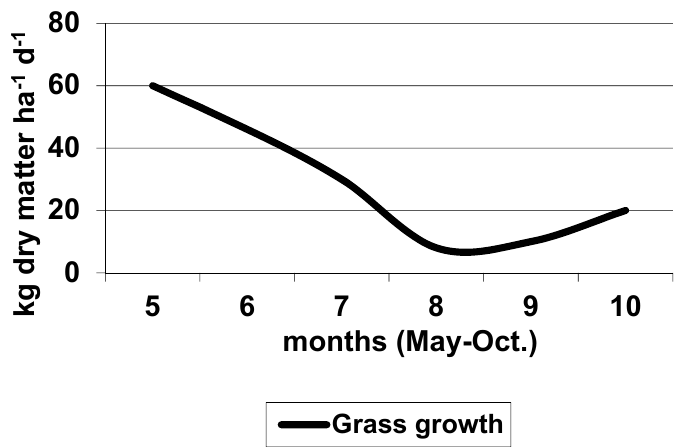
Figure 2. The average growth of pasture grass in Southern Italy [modified from 94].